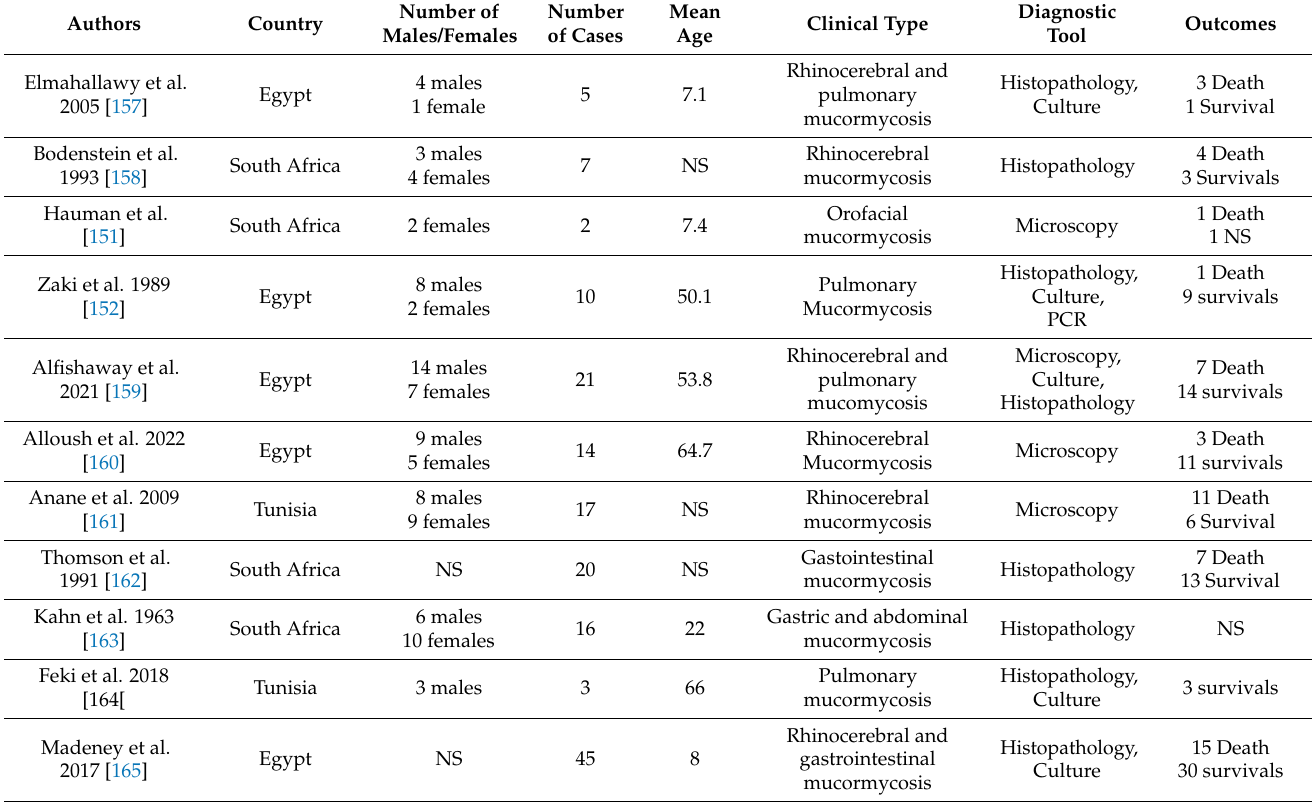
Table 6. Published cases of Mucormycosis in